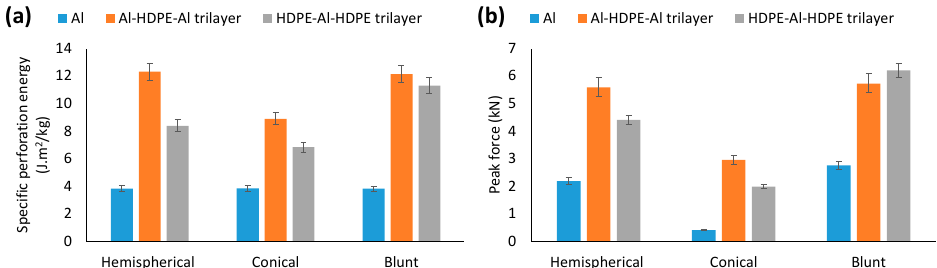
Figure 12. Comparison of ( a ) perforation energy and ( b ) peak force to failure for Al–HDPE–Al and HDPE–Al–HDPE trilayers under hemispherical, conical and blunt indenters.